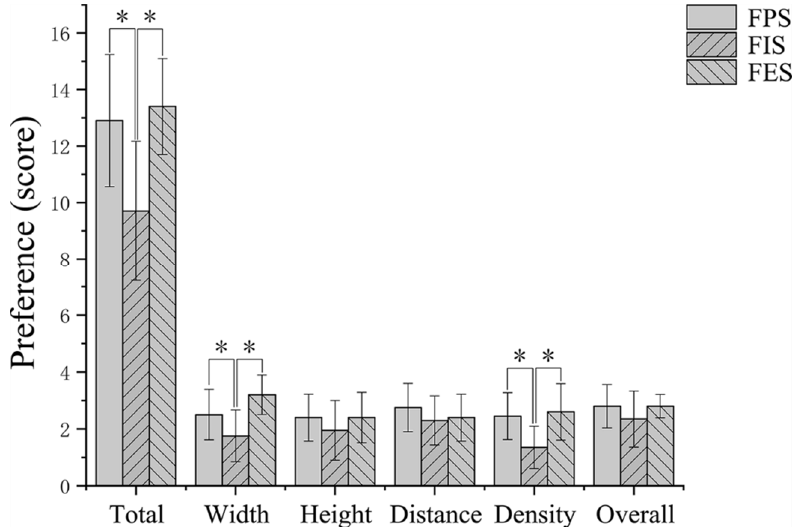
Figure 8. Spatial scale questionnaire scores among the three groups ( N = 20; mean ± standard error; * p < 0.05; ** p < 0.01).